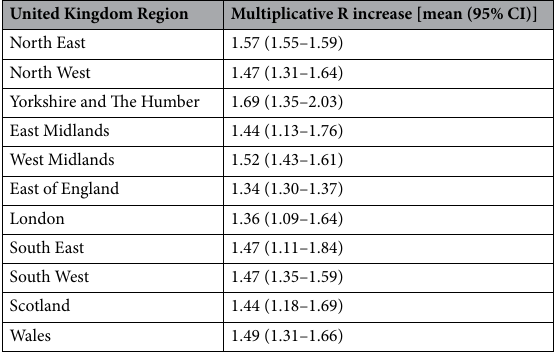
Table 2. Increase in R(t) for Delta versus Alpha SARS-CoV-2 variants. R(t) is reported for regions in Great Britain (data from Northern Ireland insufficient to reliably conduct the